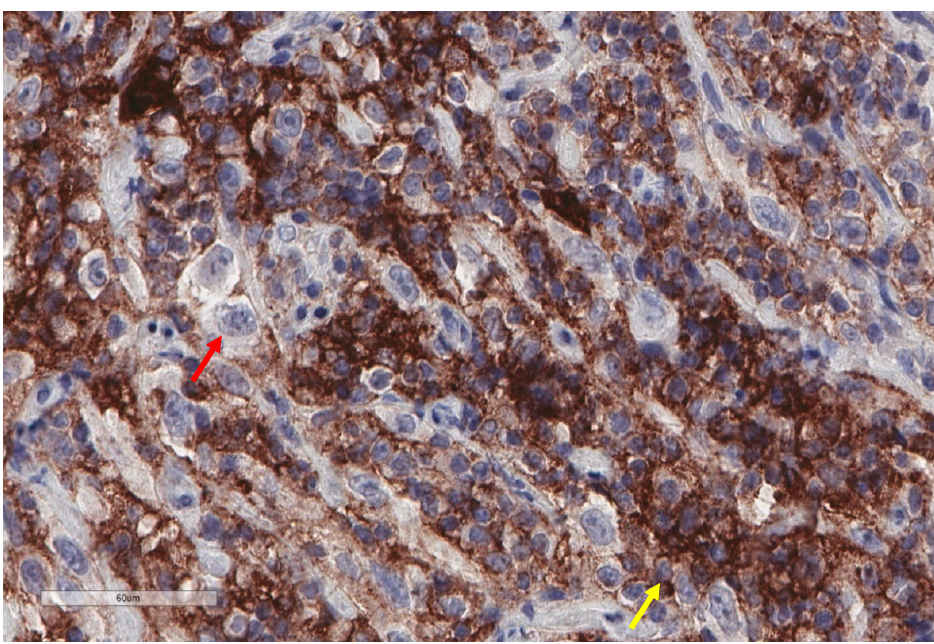
Figure 7. Abundant PD-L1 expression in this case of malignant mesothelioma (X400). Most stained cells probably correspond to immune cells (smaller size, less atypia; yellow arrow), while most tumour cells show no membranous staining (red arrow). However, further markers in conjunction to PD-L1 would be necessary to better characterize the two cell populations.